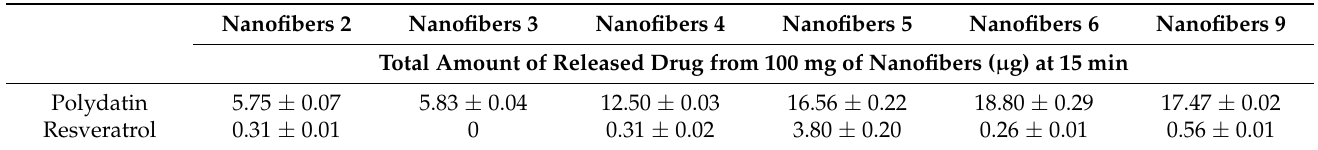
Table 7. Total Amount of Released Polydatin and Resveratrol from Nanofibers at 15 Minutes.